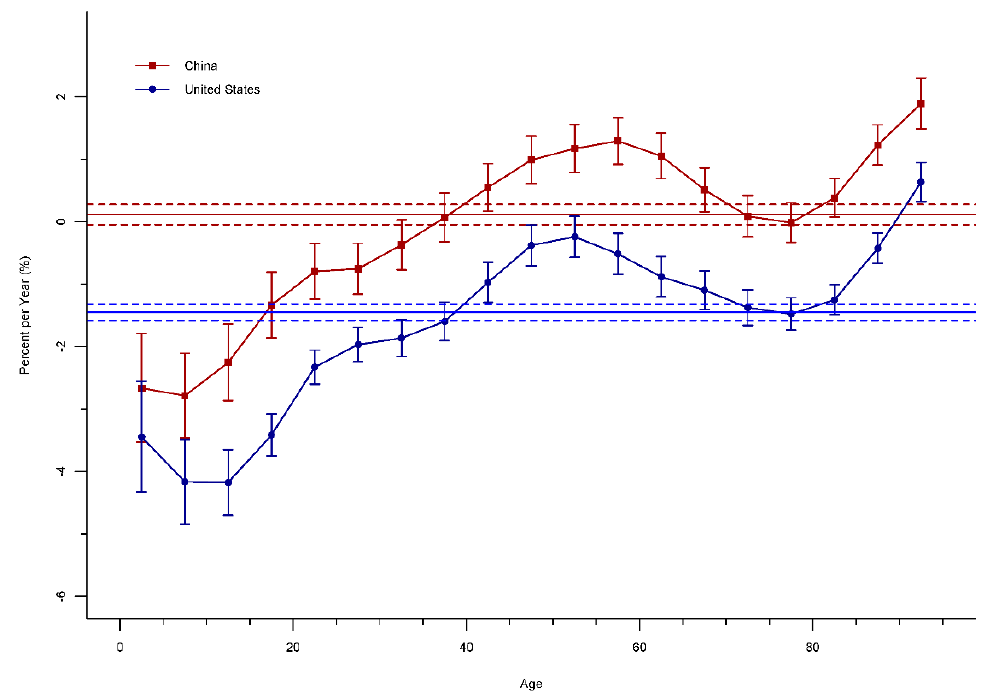
Figure 6. Local drift and net drift with 95% confidence intervals in road injury mortality for China and the United States.